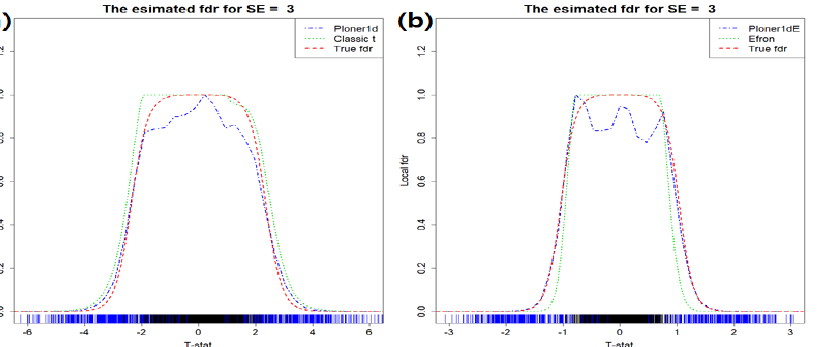
Figure 9. Scale change scenario and two-sided. Estimated fdr1ds by ( a ) Classic t and Ploner1d ( b ) Efron and Ploner1dE when k = 4.